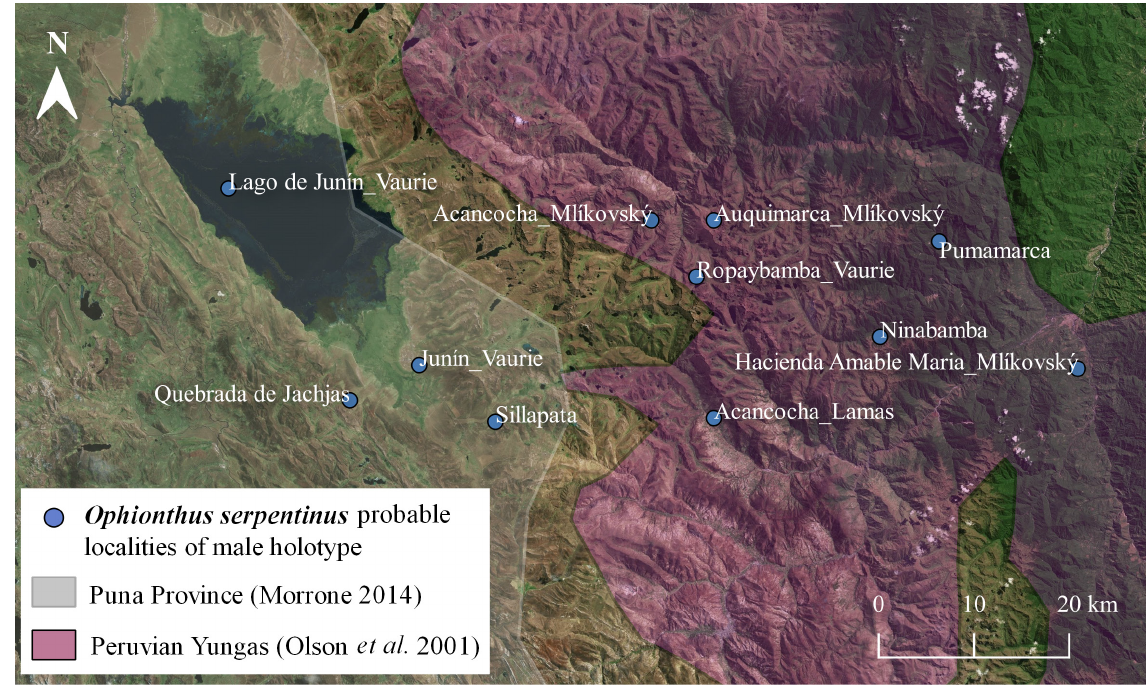
Fig. 5. Map of probable localities (correct spelling, see Supp. file 1) for the male holotype of Ophionthus serpentinus Bernhauer, 1908 collected in “Peruvia centralis” by Jelski in 1873